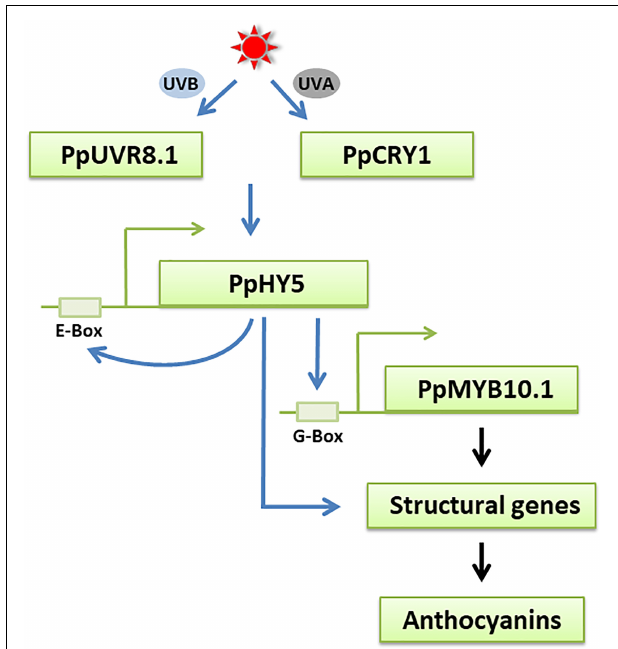
FIGURE 8 | A possible model for UVA- and UVB-induced anthocyanin biosynthesis in peach fruit. The UV light receptors PpCRY1 and PpUVR8.1 respectively perceive UVA and UVB light signals and influences the expression of PpHY5 , an essential regulator in UVA and UVB signaling pathway. PpHY5 positively induces its own transcription by interacting with an E-box in its own promoter and activates the expression of PpMYB10.1 to regulate anthocyanin accumulation. The transcription of anthocyanin biosynthetic structural genes is directly regulated by PpMYB10.1 and some of them were also regulated by PpHY5 . The blue arrows indicate the pathways verified in the present work. The black arrows indicate the pathways that have been previously reported in